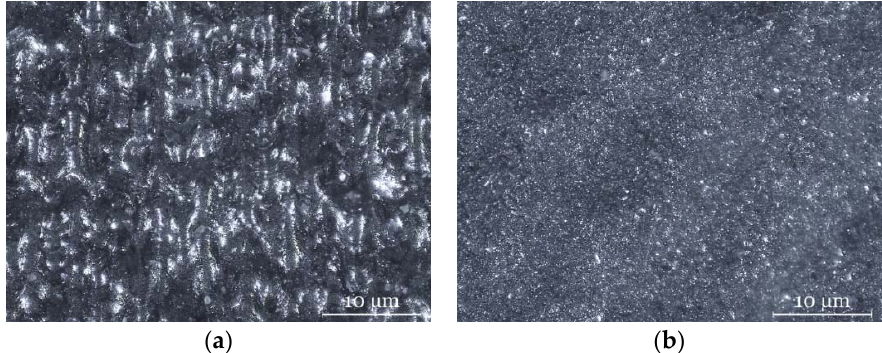
Figure 3. Microscope images at 92 × magnification: ( a ) pre-sandblasting SLM part; ( b ) post-sandblasting SLM part.